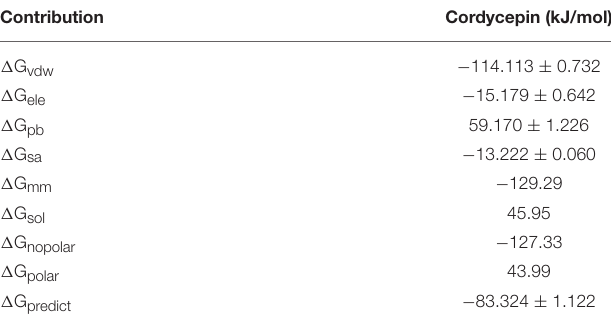
TABLE 4 | Predicted binding free energy and its individual terms (kJ/mol).